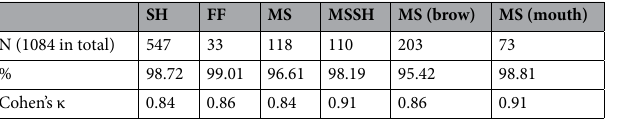
Table 2. Percentage agreements and Cohen’s kappa coefficients for the six facial expression types.